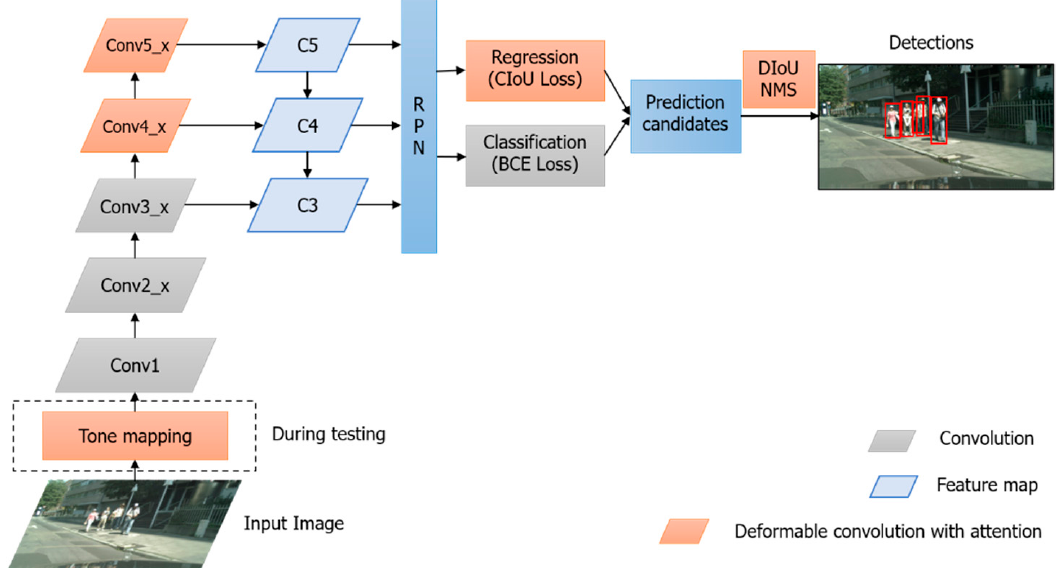
Figure 3. The architecture of our proposed deformable attention-guided network (DAGN) for pedestrian detection. The baseline detector is the cascade R-CNN [31] with the structure of feature pyramid networks (FPN) [32]. C3 to C5 denote the feature maps of the corresponding conv3 to conv5 stages of the ResNet50. The improved parts in our method are highlighted in red color.